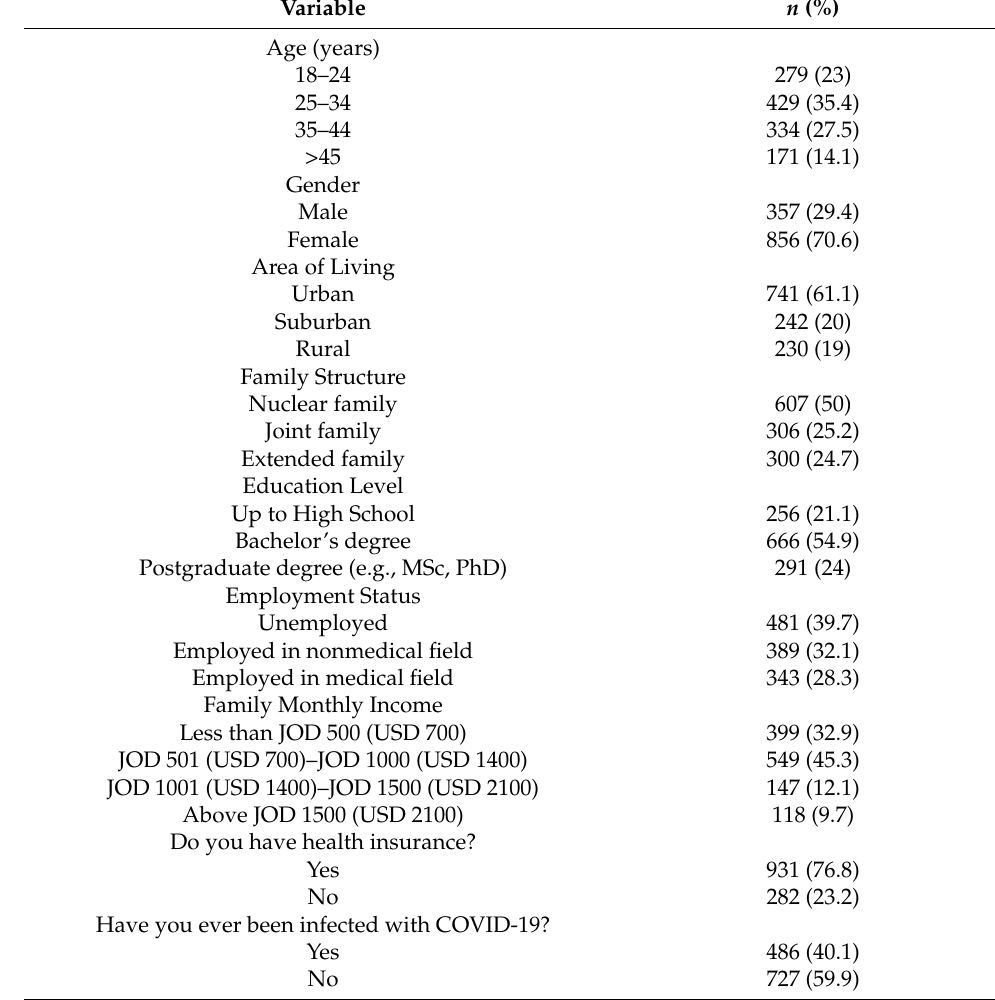
Table 1. Percentage distribution of selected demographic variables of the participants in the sample ( n =